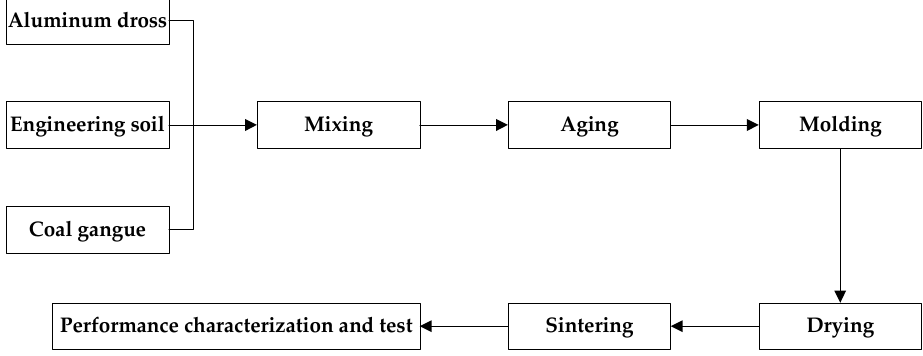
Figure 3. The process flow of sintered brick preparation.